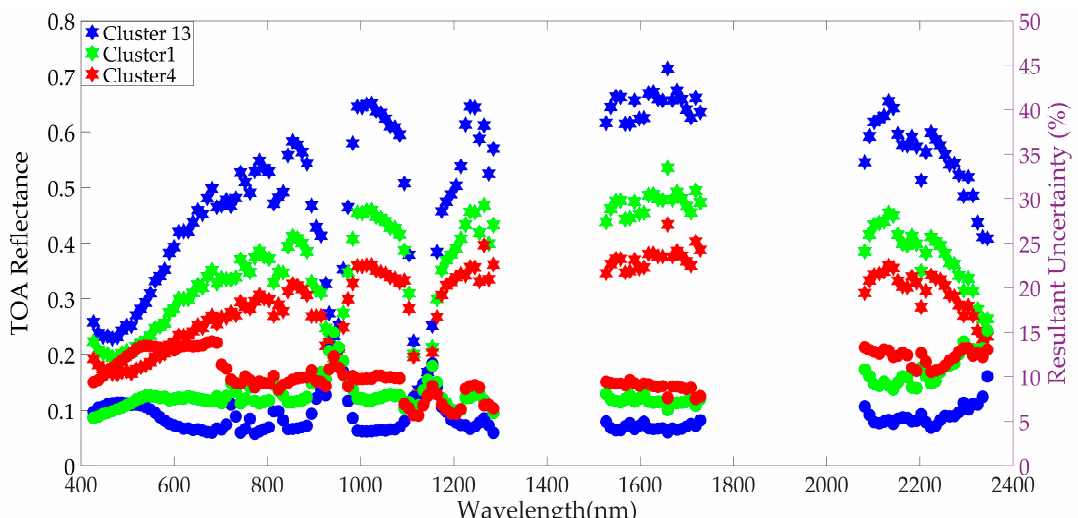
Figure 22. Comparison of the hyperspectral profile of different clusters with its temporal uncertainty (1-sigma). The solid hexagrams represent a representative hyperspectral profile of a cluster and its corresponding temporal uncertainty is represented by the solid circle of the same color.